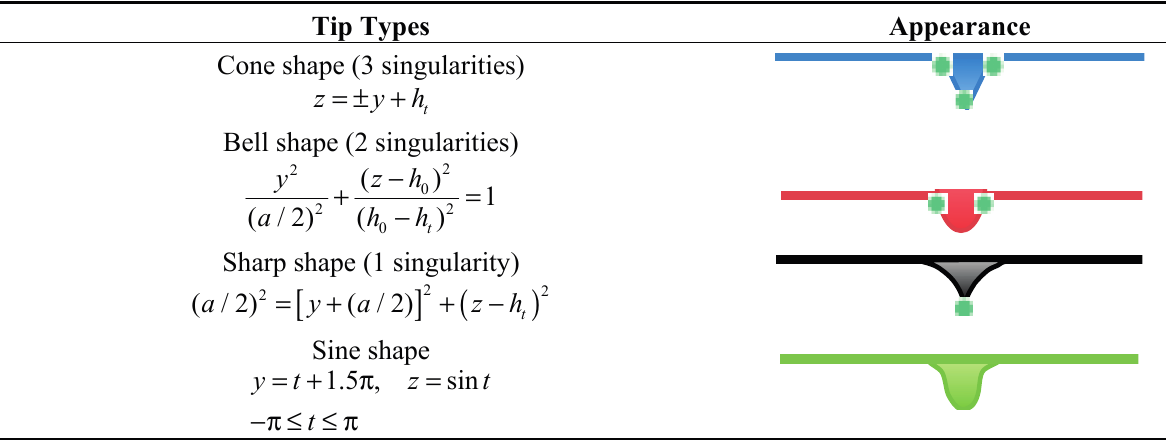
Table 1. The different types of tip